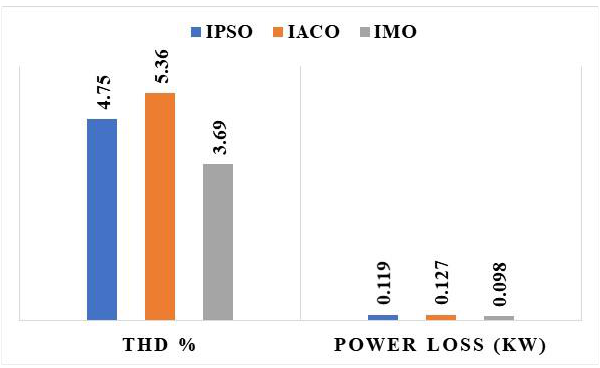
Figure 9. Performances of THD and power loss.